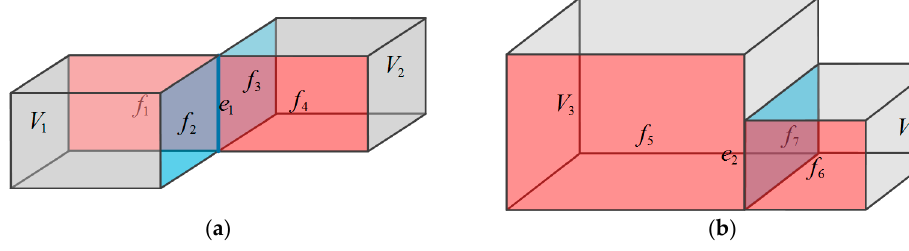
Figure 13. Two examples of identifying redundancies based on the proposed conditions: ( a ) a non-manifold spatial unit; and ( b ) a spatial unit consisting of two adjacent volumes.